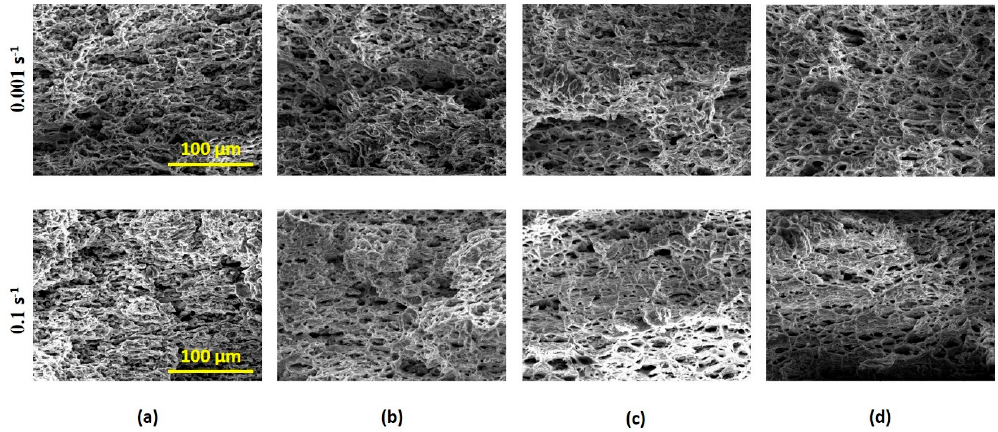
Figure 8. Fracture surfaces of ( a ) as-received (AA7075-T6 aluminum alloy), ( b ) the solution heat- treated condition, ( c ) the sample processed in a die with a temperature of 24 °C, and ( d ) the sample processed in a die with a temperature of 350 °C after tensile tests at the temperature of 350 °C and strain rates of 0.001 s − 1 and 0.1 s − 1.